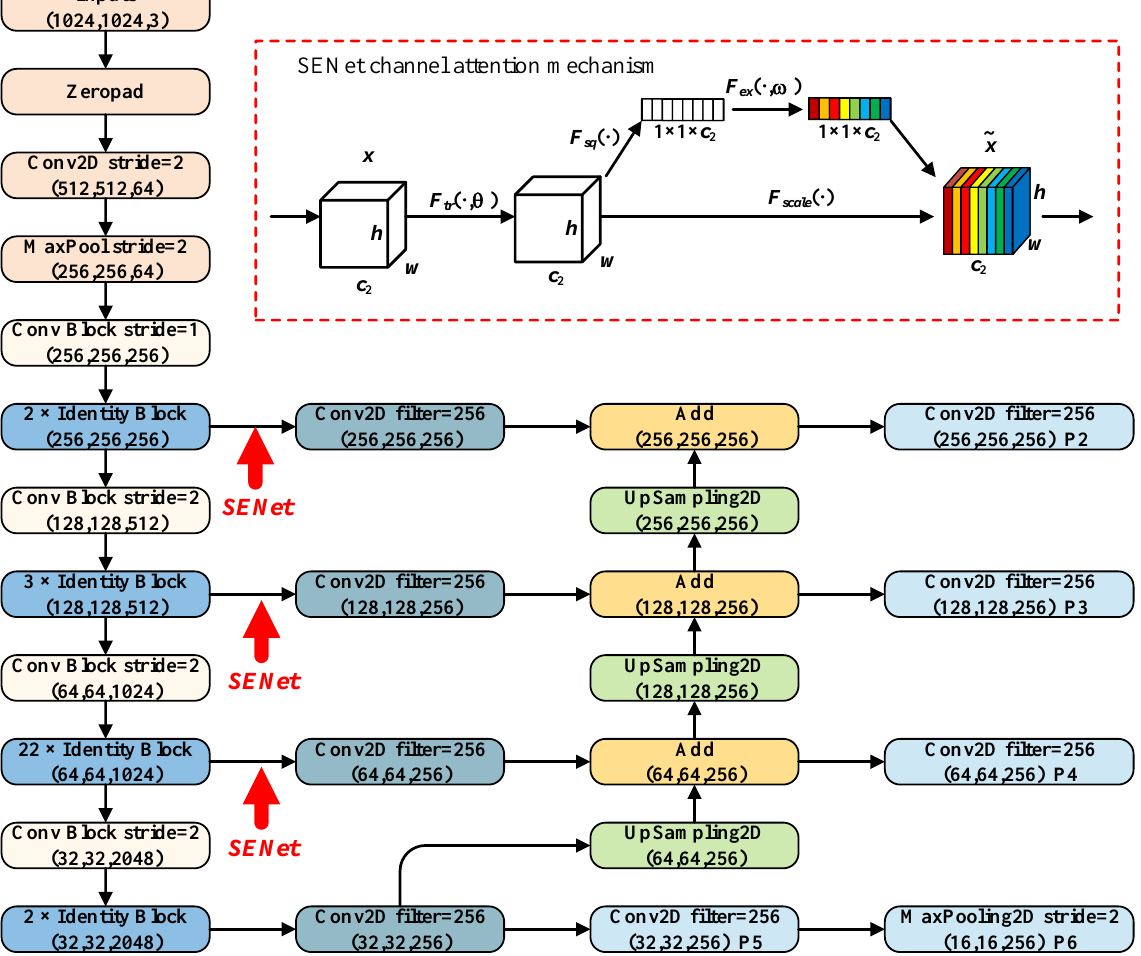
Figure 4. The structure of Resnet101 with the introduction of the SENet attention mechanism.